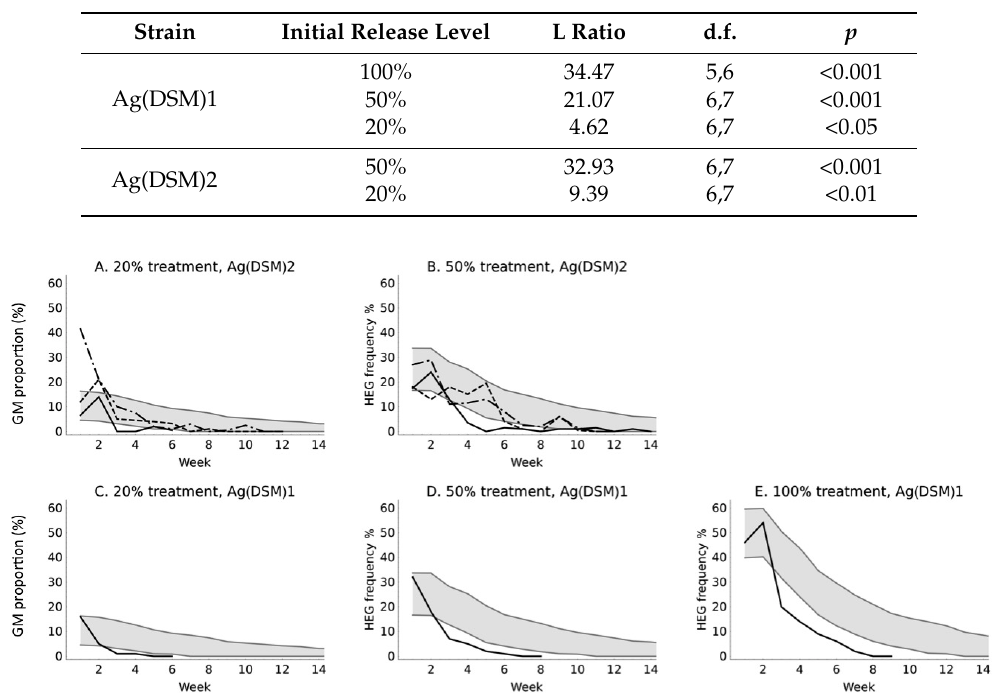
Table 1. The log ratio and likelihood of the experimental data conforming to the predictions of the disappearance model as a function of the initial release density and transgenic line.